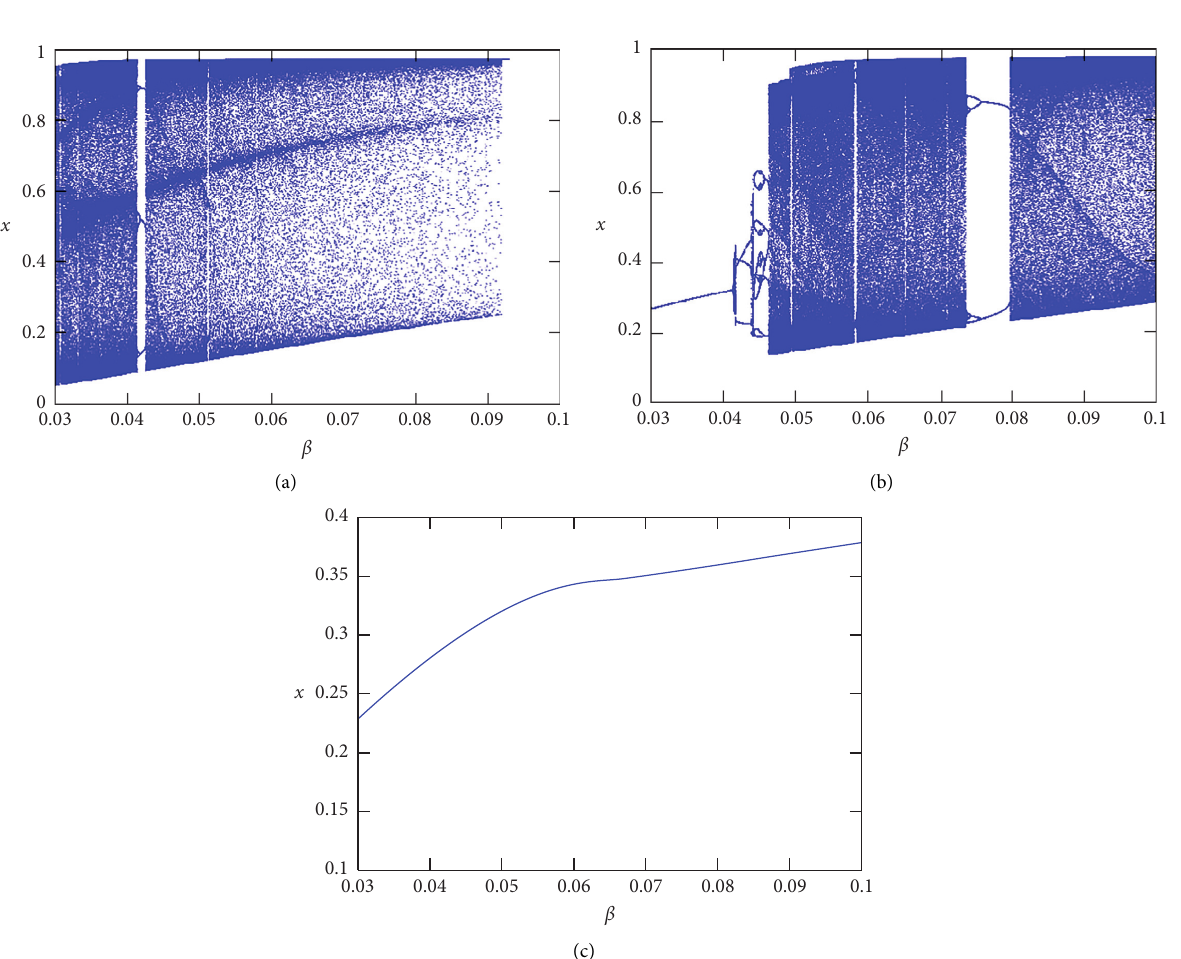
Figure 6: Effect of α on bifurcation diagram of nonlinear chemical reaction with ω � 0.0481, f � 0.00165, and g � 0: (a) α � 0.02; (b) α � 0.03; (c) α �